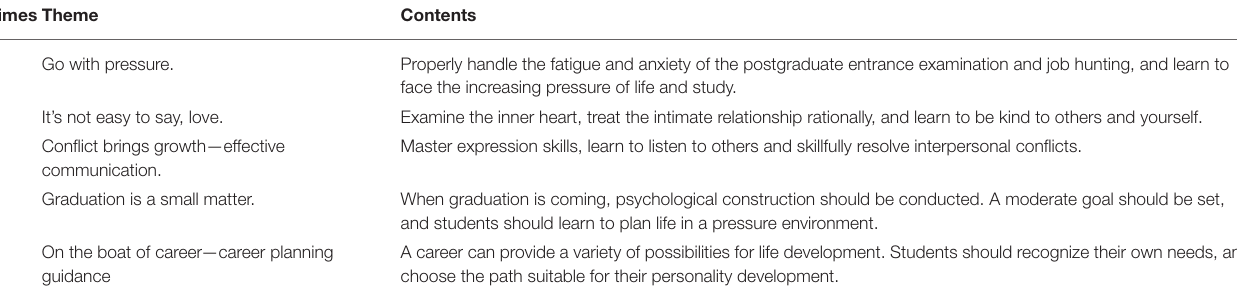
TABLE 3 | Teaching the topics and overview of the digital school-based course of mental health education. Times Theme